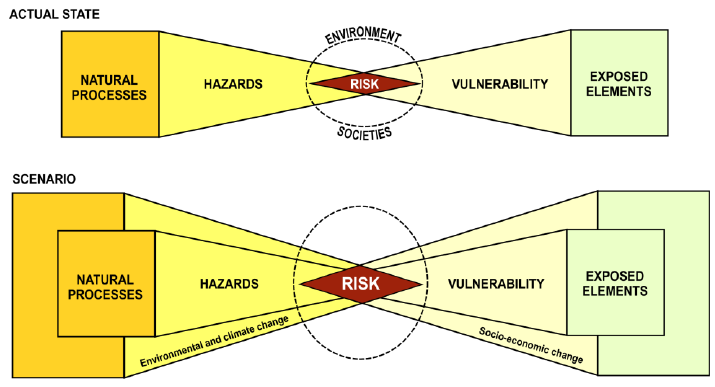
Figure 1. How risk is affected by socio-economic and climate change [31].